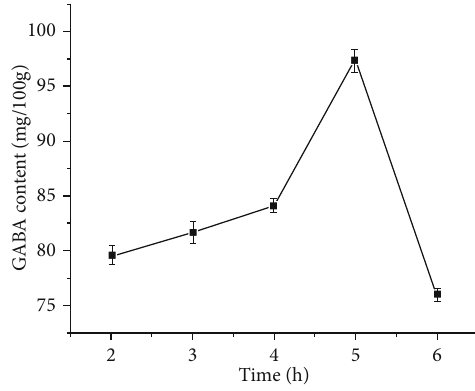
Figure 3: E ff ect of temperature on GABA content. Figure 4: E ff ect of time on GABA content.